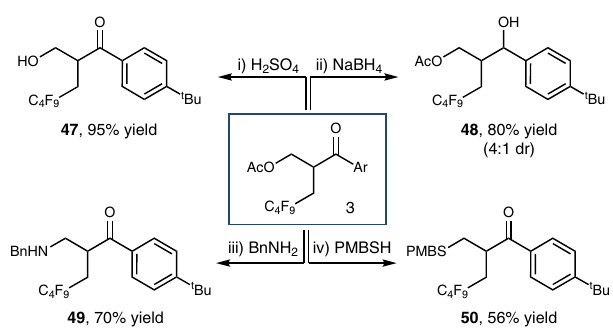
Fig. 4 Derivations of compound 3 . See Supplementary Methods. Ar = 4- tert -butylphenyl. PMB =